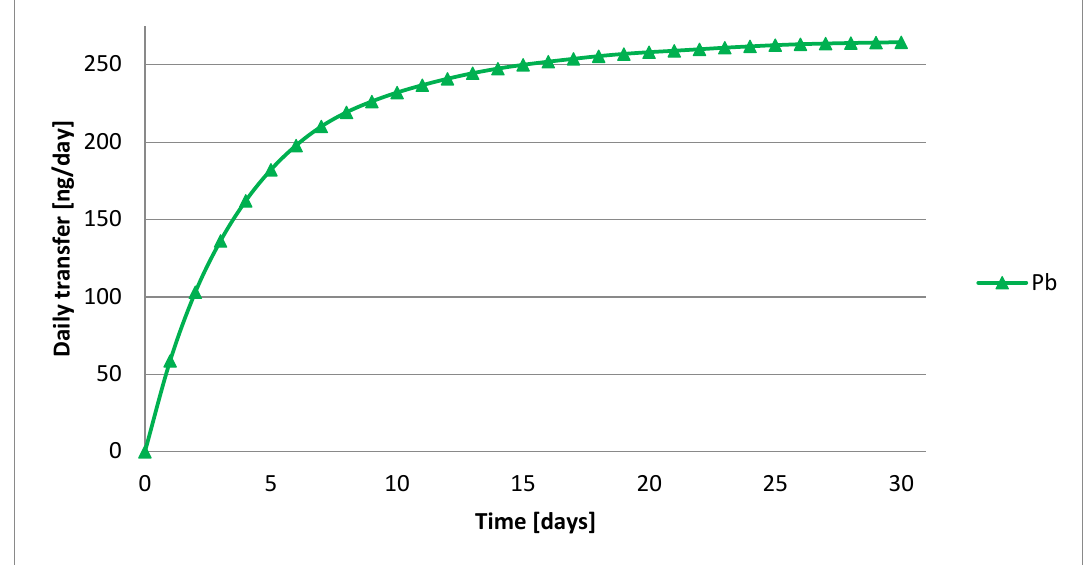
Figure 10. Transfer of contaminant from kidneys to urine (subject 1). Lead (Pb).